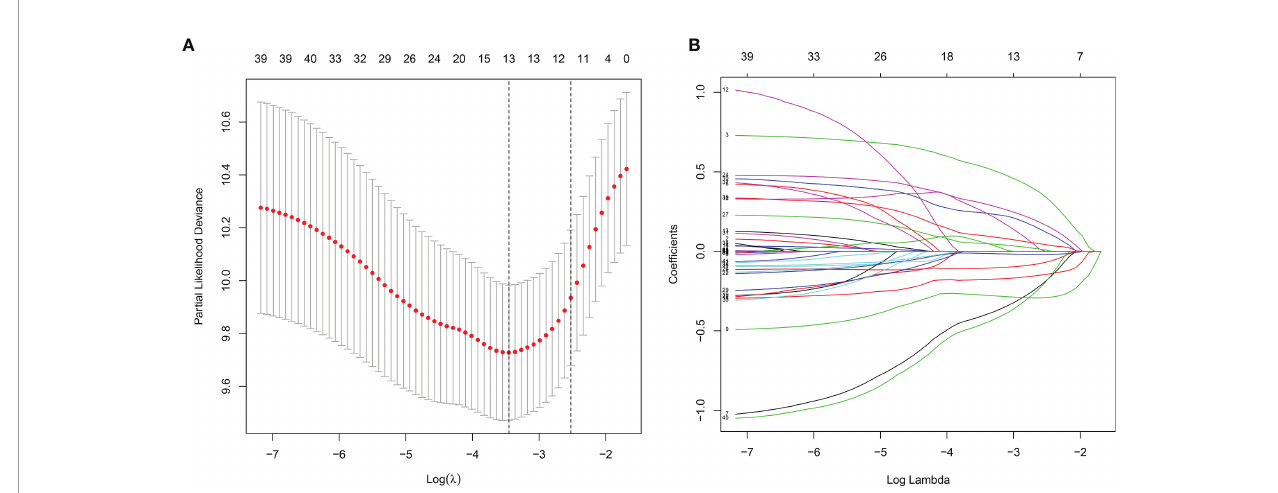
FIGURE 1 | The LASSO coef fi cient pro fi les of immune-related genes. The optimal number of variables was determined using LASSO regression analysis. (A) 10-fold cross veri fi cation for selecting lambda in the LASSO model on the basis of the minimum criteria. (B) The optimal number of variables was determined using LASSO regression